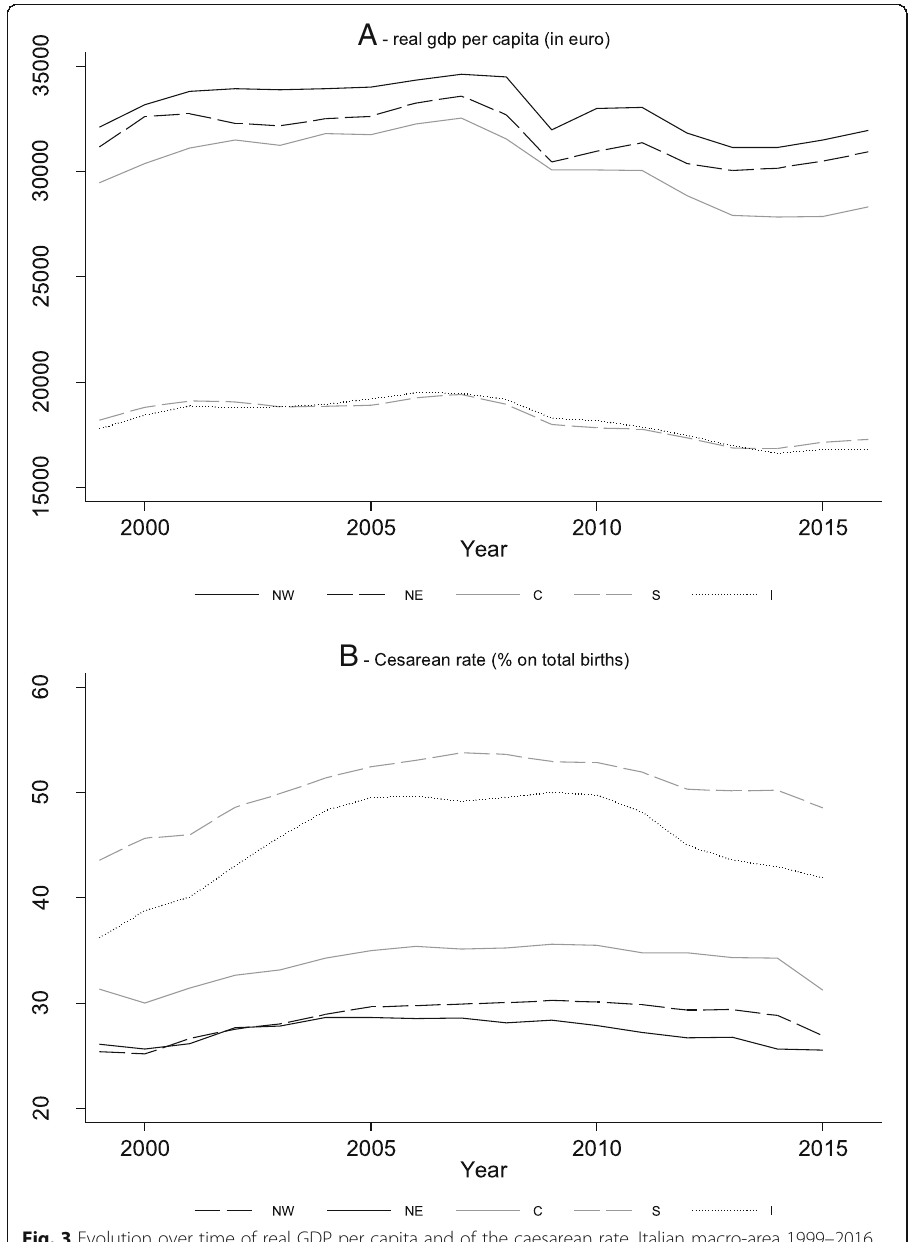
Fig. 3 Evolution over time of real GDP per capita and of the caesarean rate, Italian macro-area 1999 –